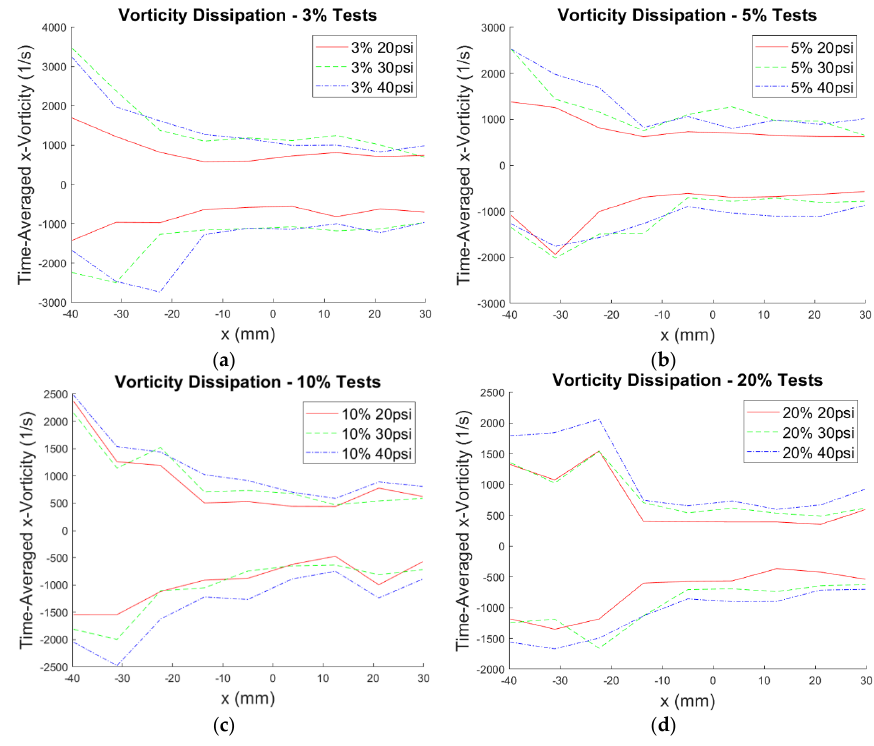
Figure 21. Vortex dissipation through tomography region for ( a ) 3%, ( b ) 5%, ( c ) 10%, and ( d ) 20% freestream wind tunnel settings. Fluids 2020 , 5 , x FOR PEER REVIEW